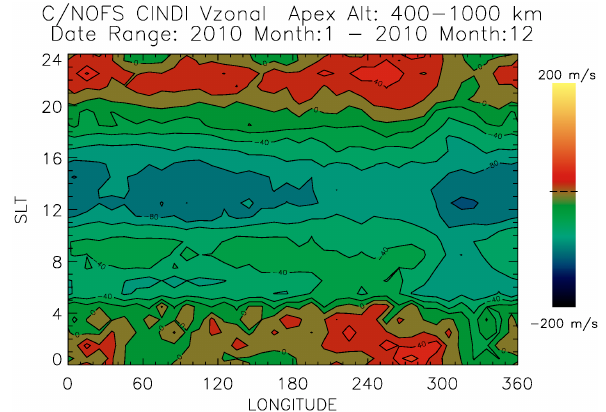
445 Figure 5. Contour plot of CINDI zonal velocities versus SLT (hours) and longitude 446 for the year 2010. All available data in the 400–1000 km apex altitude range was 447 Fig. 5. Contour plot of CINDI zonal velocities versus SLT (hours) used. 448 and longitude for the year 2010. All available data in the 400– 449 1000km apex altitude range were